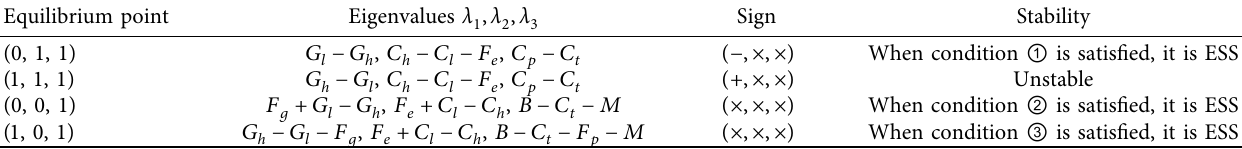
Table 3: Asymptotic stability of the equilibrium point in noncollusion.